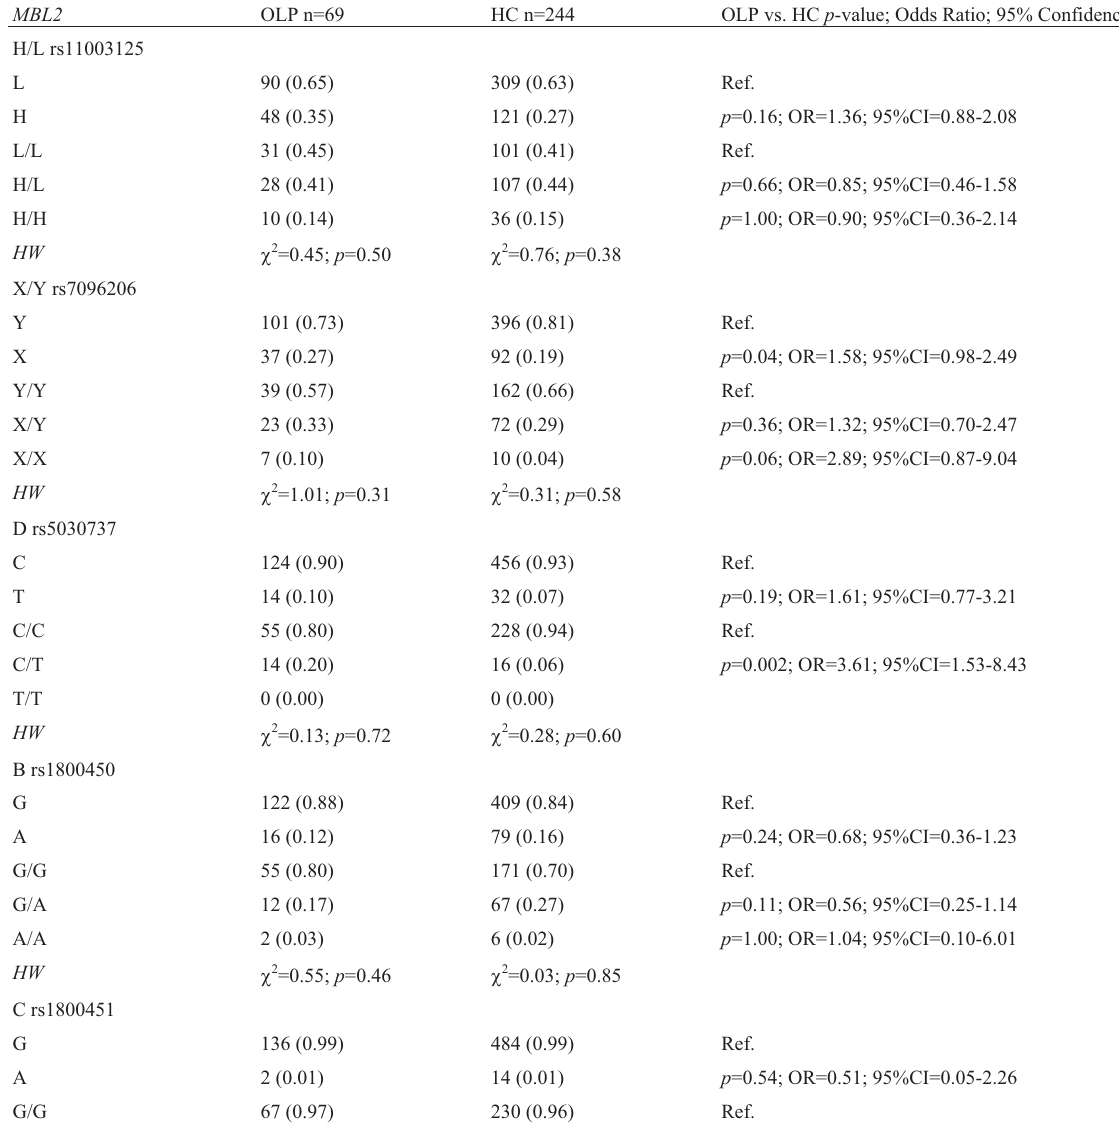
Table 1 - MBL2 polymorphisms allele, genotype and haplotype counts (and frequency) in OLP patients (OLP) and healthy subjects